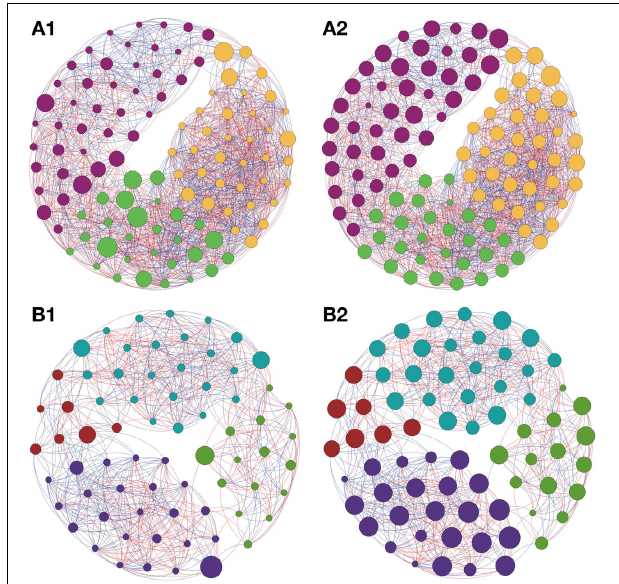
FIGURE 5 | Network interactions of soil bacterial genus found in Sugarcane (A1, A2) and in the Pinus plantation (B1, B2) on Cerrado biome. A connection stands for a strong Pearson’s correlation ( p ≥ 0 . 9 and P -value ≤ 0.05). Each circle (usually called node) represents a bacterial genus and the sizes of the circles are proportional to the value of betweenness centrality in (A1) and (B1) . In (A2) and (B2) the sizes of the circles are proportional to value of closeness centrality. Lines connecting two bacterial genera represent the interactions between them. Blue lines represent the positive significant correlations and red lines represent a negative significant correlation. The colors of the circles represent the bacterial modules. For clarity, the OTU’s identity was omitted. Detailed networks containing the identity of each node can be observed in the Supplementary Figures S1–S5 and Supplementary Table